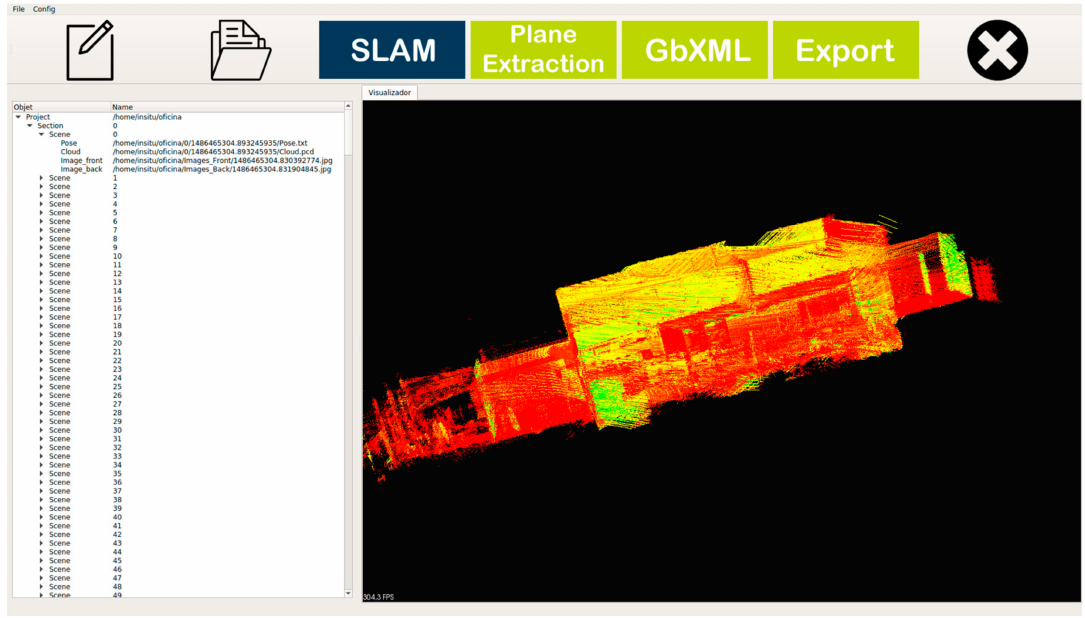
Figure 5. Main interface after SLAM. The composition tree at the left includes the individual point clouds associated to each pose of the computed